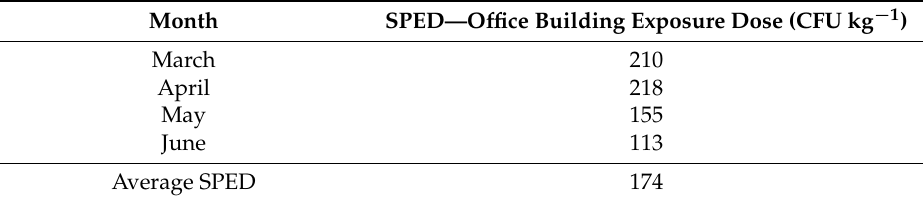
Table 5. Calculated exposure dose spring office exposure dose (SPED) of bacterial aerosol inhaled by staff of office building in four months of spring